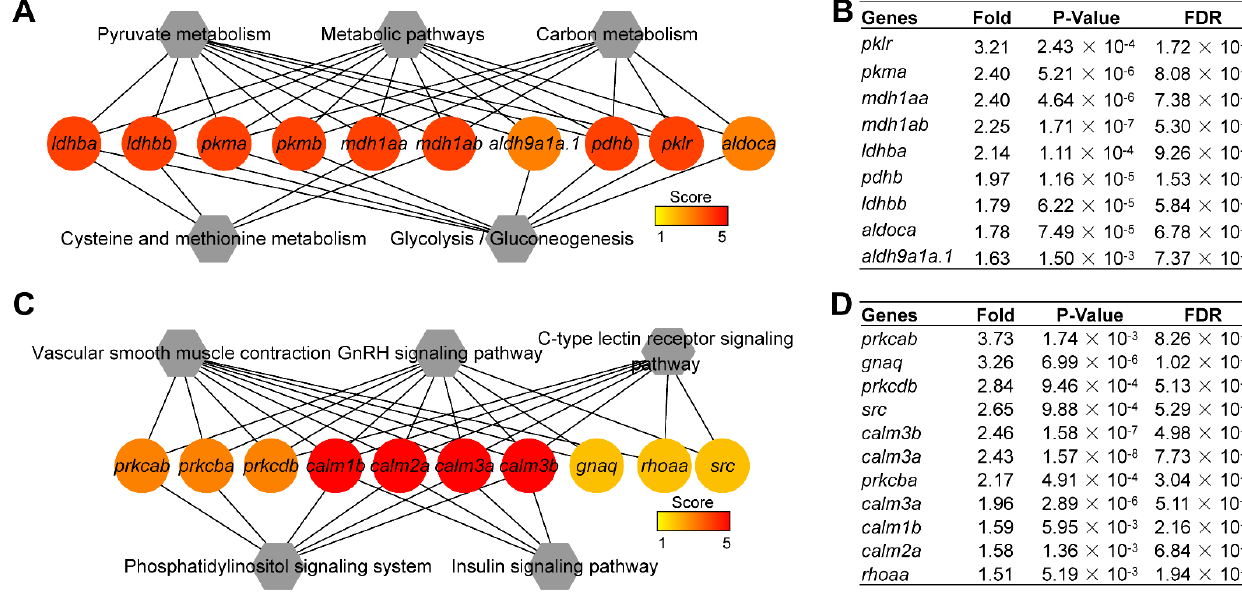
Figure 5. Hub genes within the top five hub pathways. ( A ) Network of 10 hub genes mapped to top five hub pathways enriched from up-regulated key genes. ( B ) The fold change of up-regulated hub genes in group I. FDR: false discovery rate ( C ) Network of 10 hub genes mapped to top five hub pathways enriched from down−regulated key genes. ( D ) The fold change of down−regulated hub genes in group I. Round stands for genes; hexagon represents pathways; edge means the gene mapped to the pathway in ( A , C ).